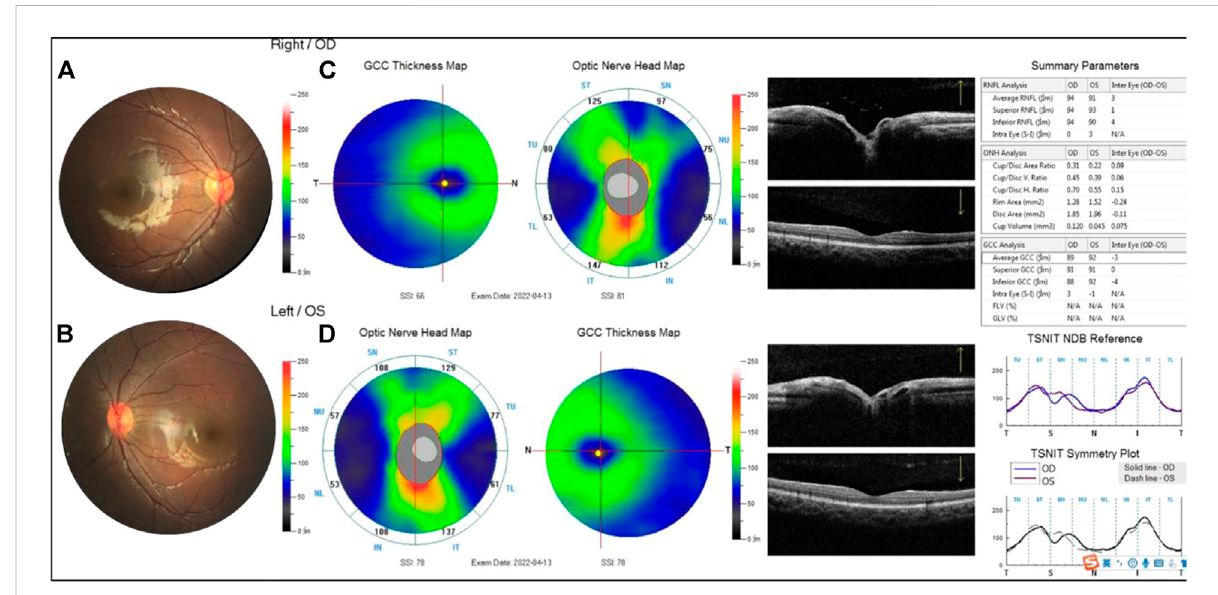
FIGURE 8 Examination results of the proband ’ s fraternal twin brother were normal (A,B) . The thickness of the superior retinal nerve fi ber layer (RNFL), inferior RNFL, and average RNFL was within the normal range. The thickness of the superior ganglion cell complex (GCC), inferior GCC, and average GCC was within the normal range (C,D) .